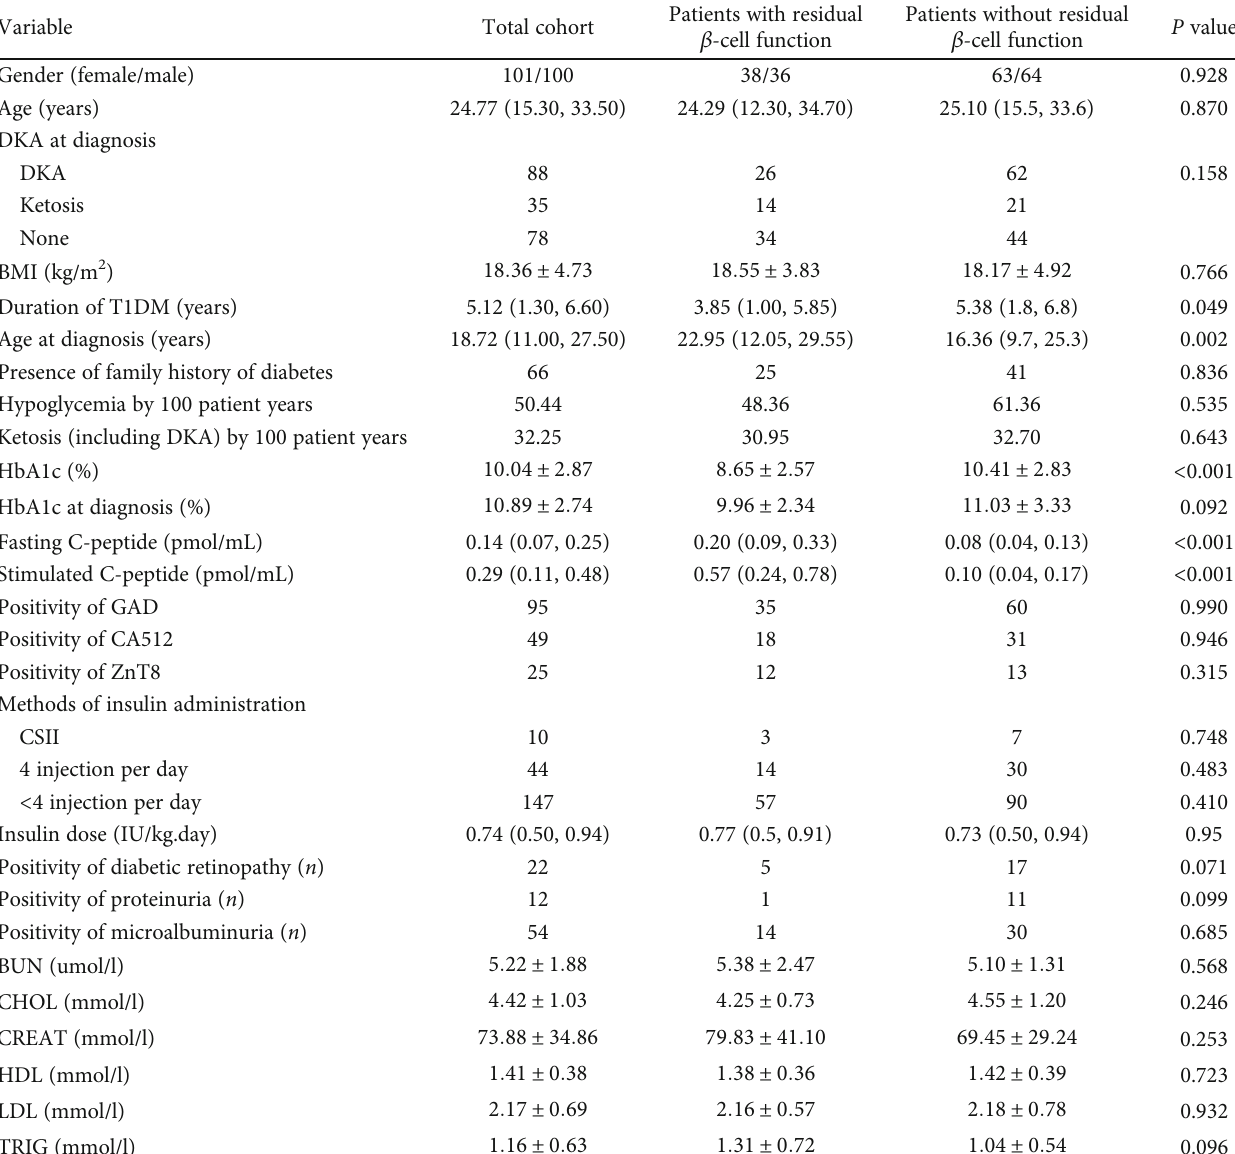
Table 1: Epidemiologic and clinical characteristics of all participants in this study.